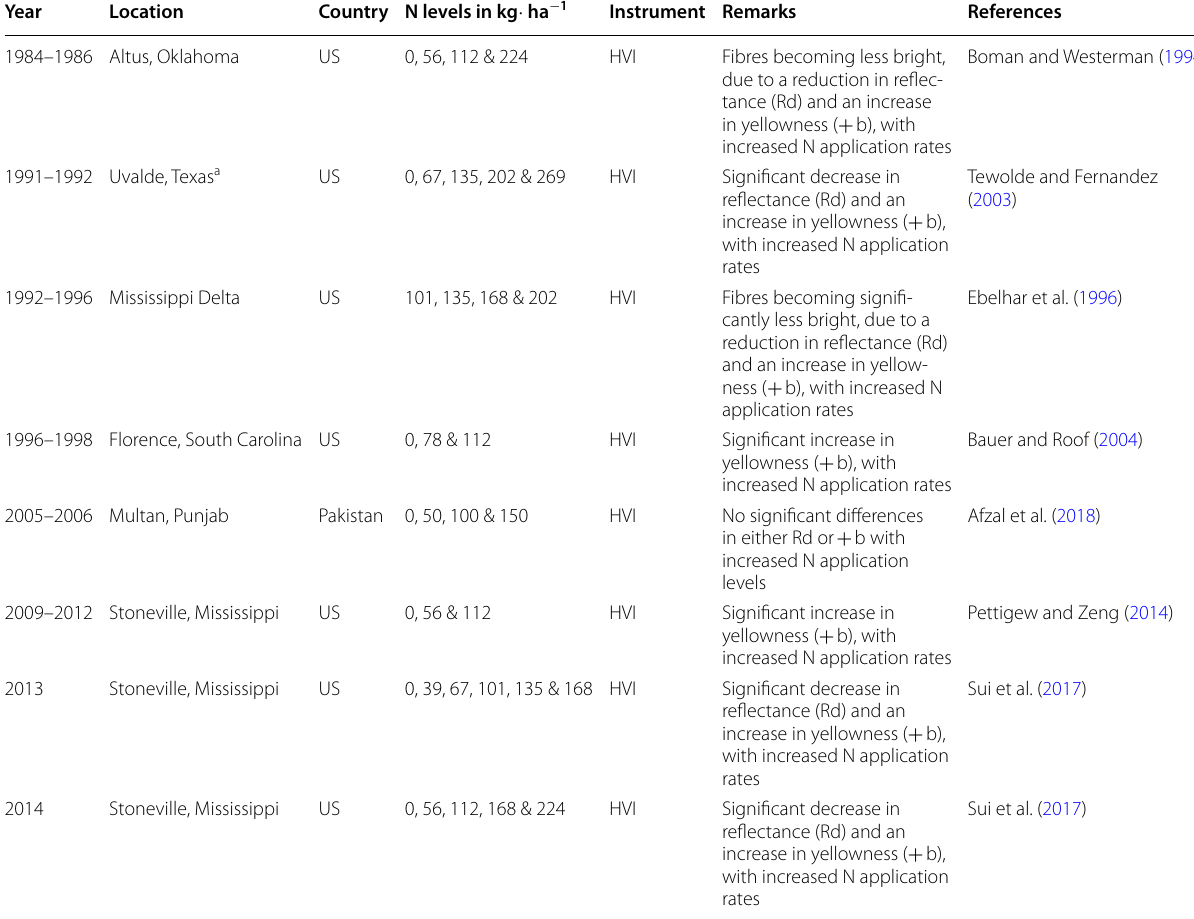
Table 5 Effect of N level on